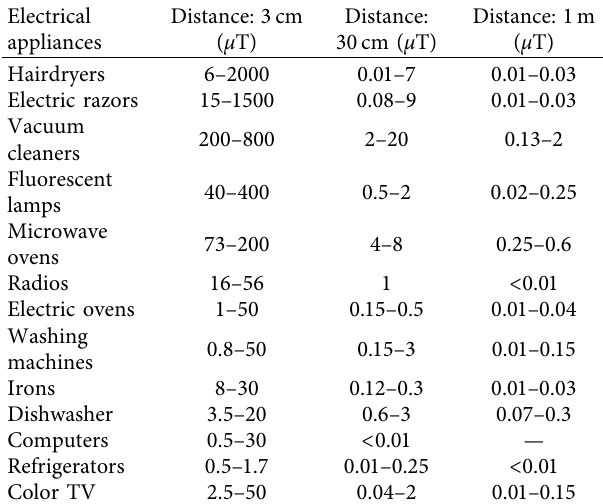
Table 2: Typical values for the magnetic fields generated by some commonly used electrical